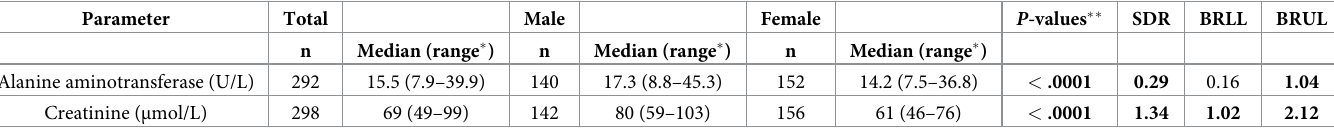
Table 2. Clinical chemistry reference intervals (median and 2.5 th —97.5 th percentiles) derived from healthy adults in Kisumu County, Kenya.